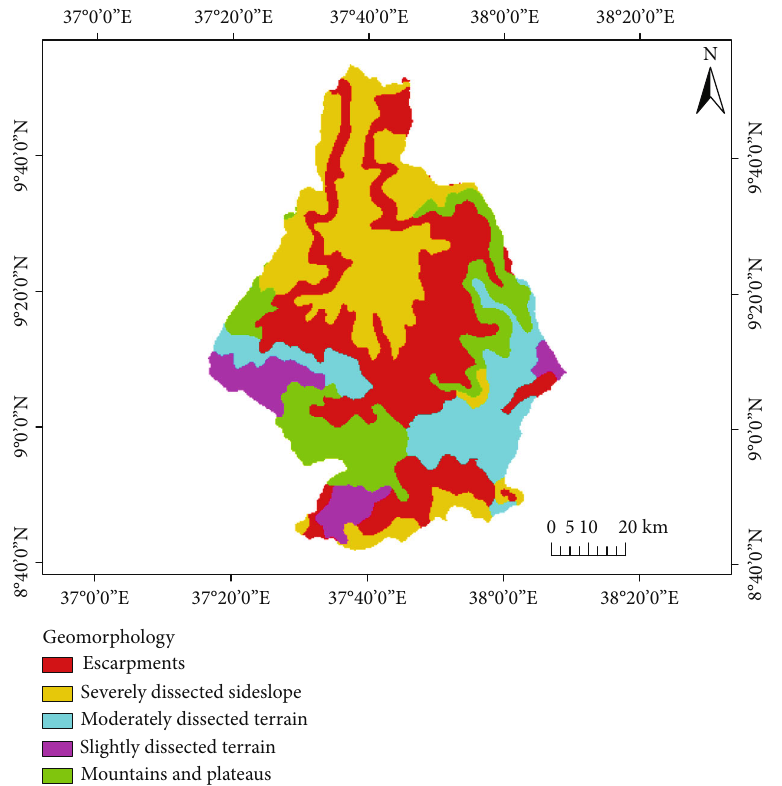
Figure 10: Geomorphology of the Guder